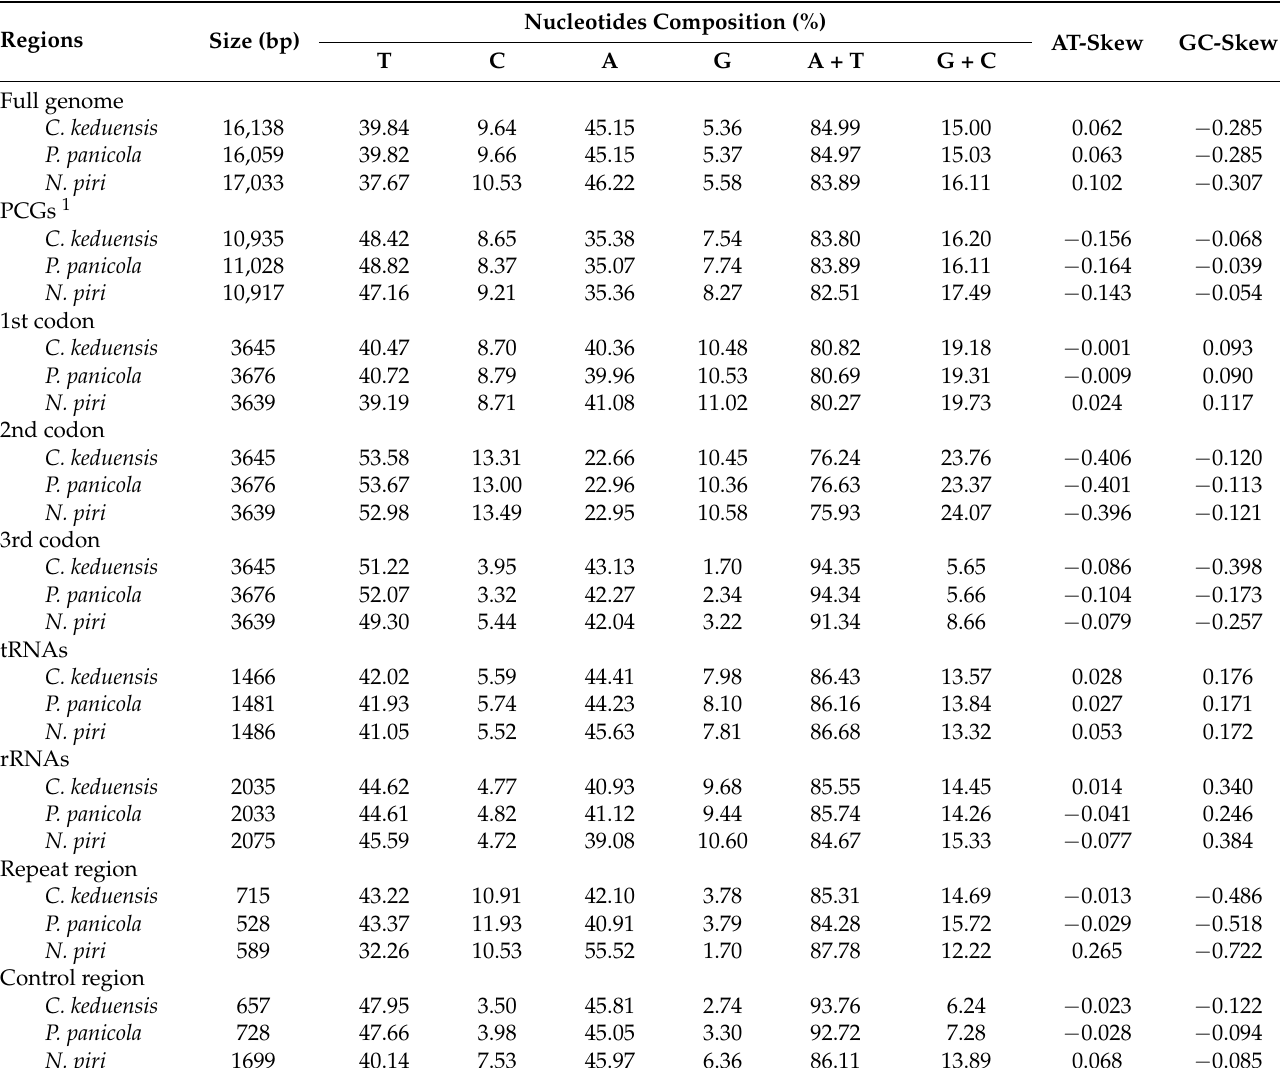
Table 2. Base composition of Ceratovacuna keduensis , Pseudoregma panicola and Nippolachnus piri